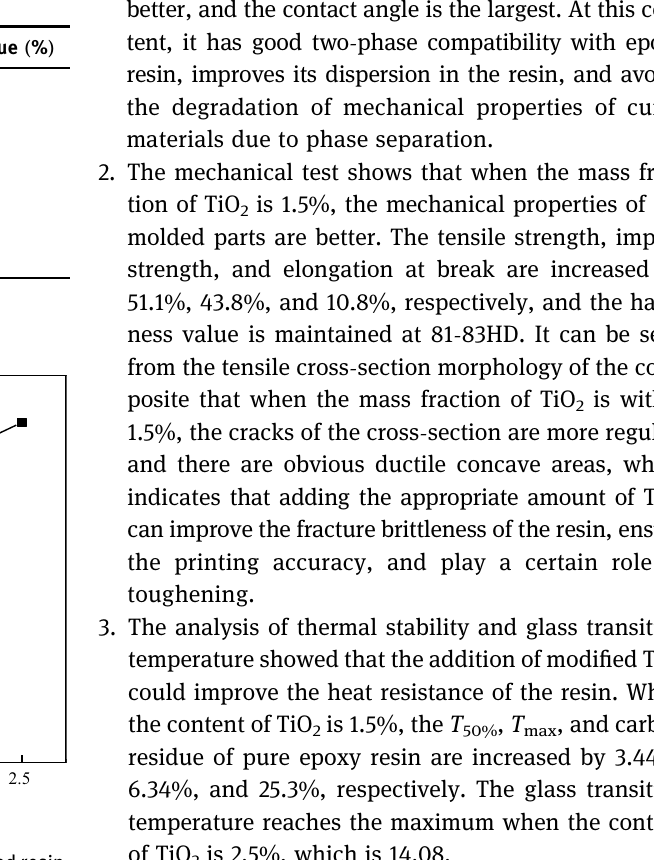
Figure 14: Glass transition temperature curve of TiO 2 - modi fi ed